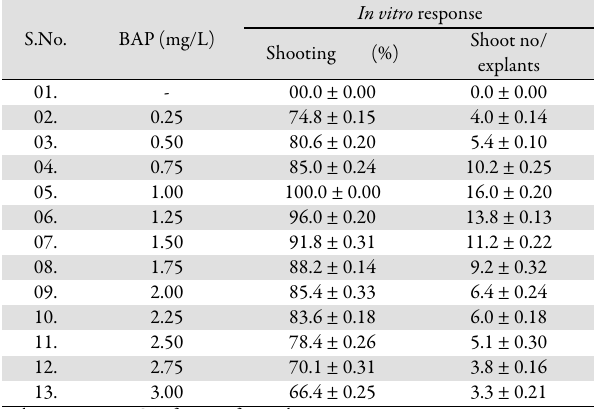
Table 1. Effect of BAP on leaf disc explants of Physalis angulata L.